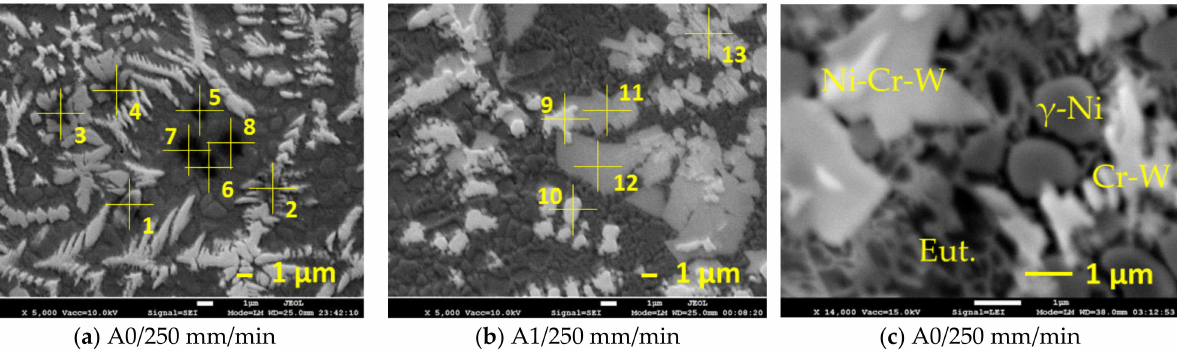
Figure 10. SEM images of the microstructure obtained without oscillation ( a ) and with oscillation amplitude A = 1 mm ( b ) at 250 mm/min laser speed; 1–13—points of EDS analysis (Table 3); ( c )— enlarged view of microstructure after etching showing four main constituents of the structure: γ -Ni—grains of nickel-based solid solution; Eut.—eutectic; Ni-Cr-W—Ni,Cr,W-rich carbides; Cr-W— Cr,W-rich